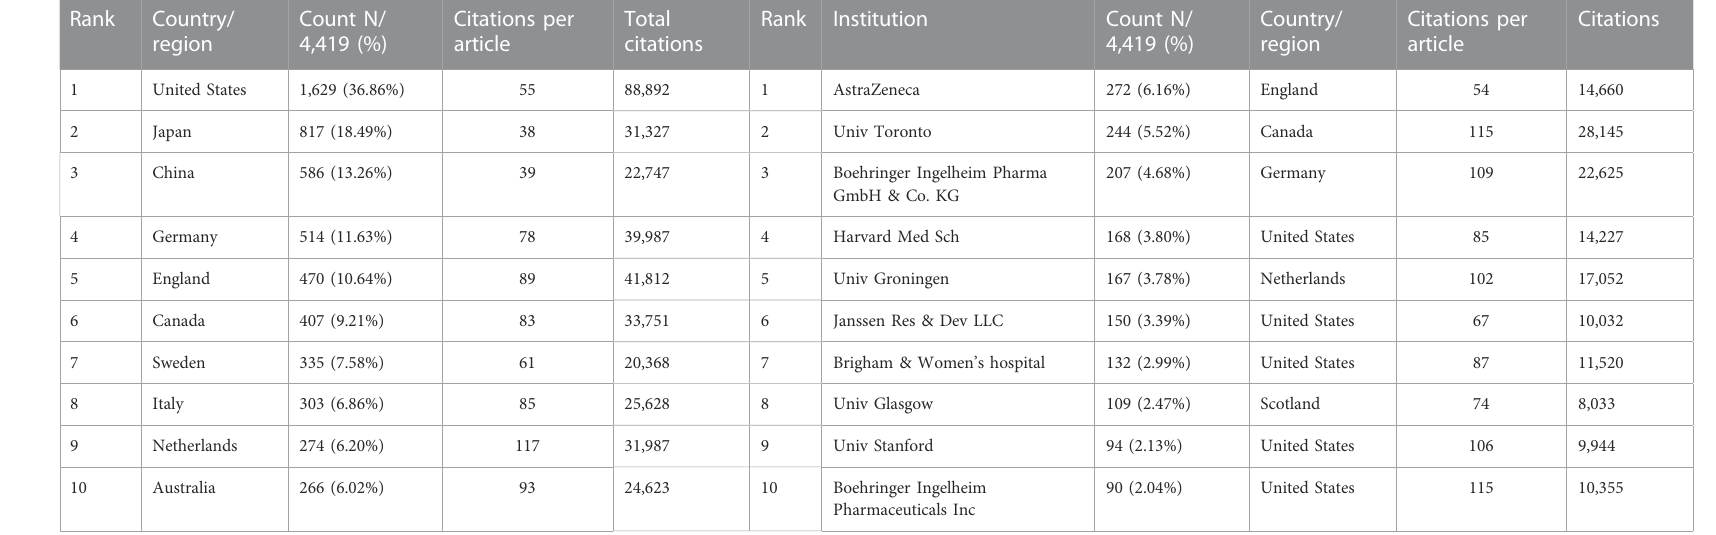
TABLE 2 Top 10 countries/regions and institutions in SGLT2 inhibitor